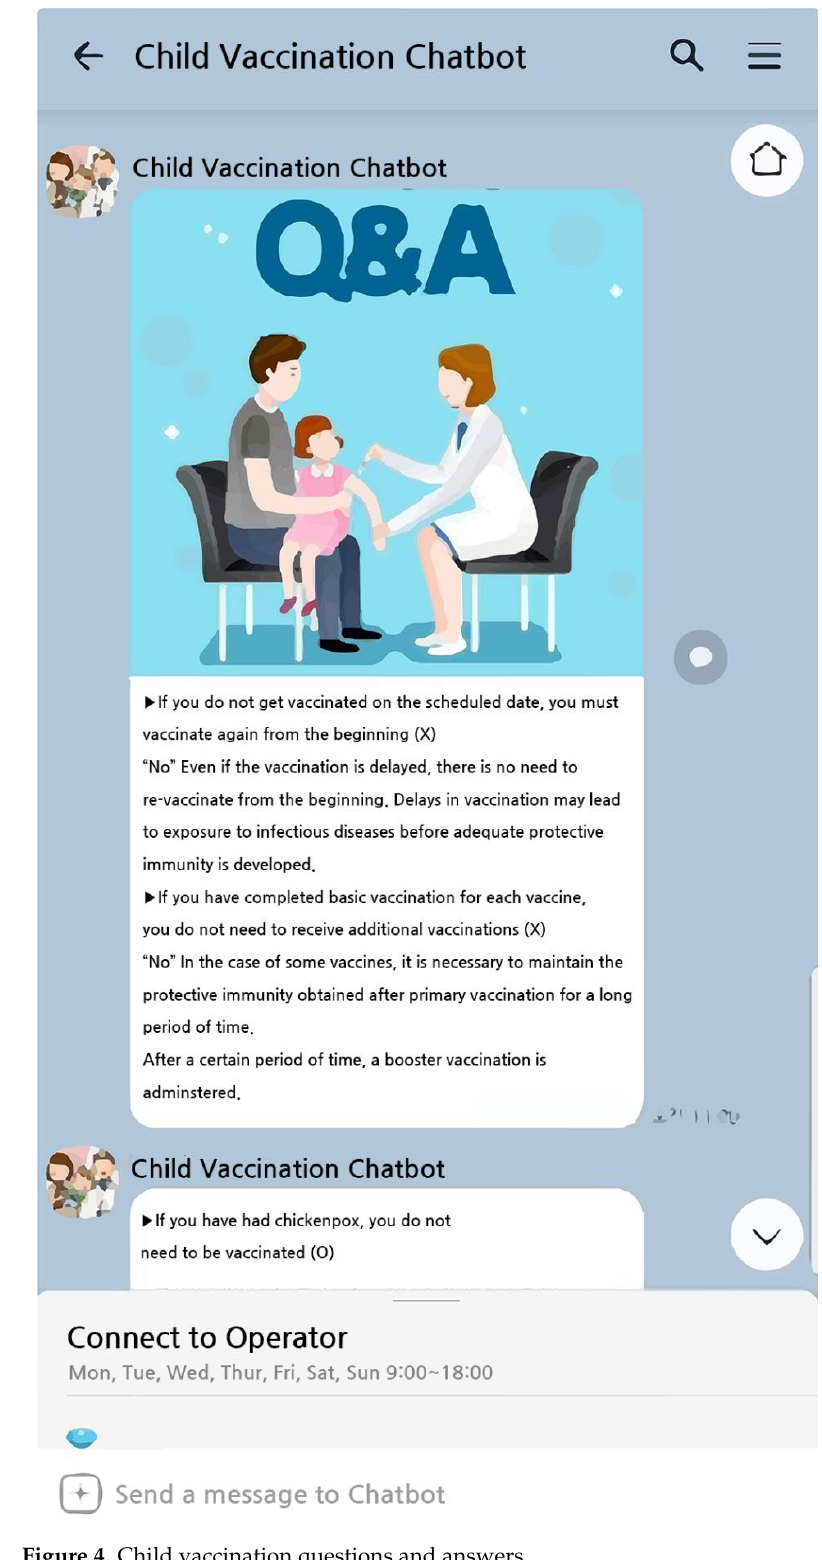
Figure 4. Child vaccination questions and answers.